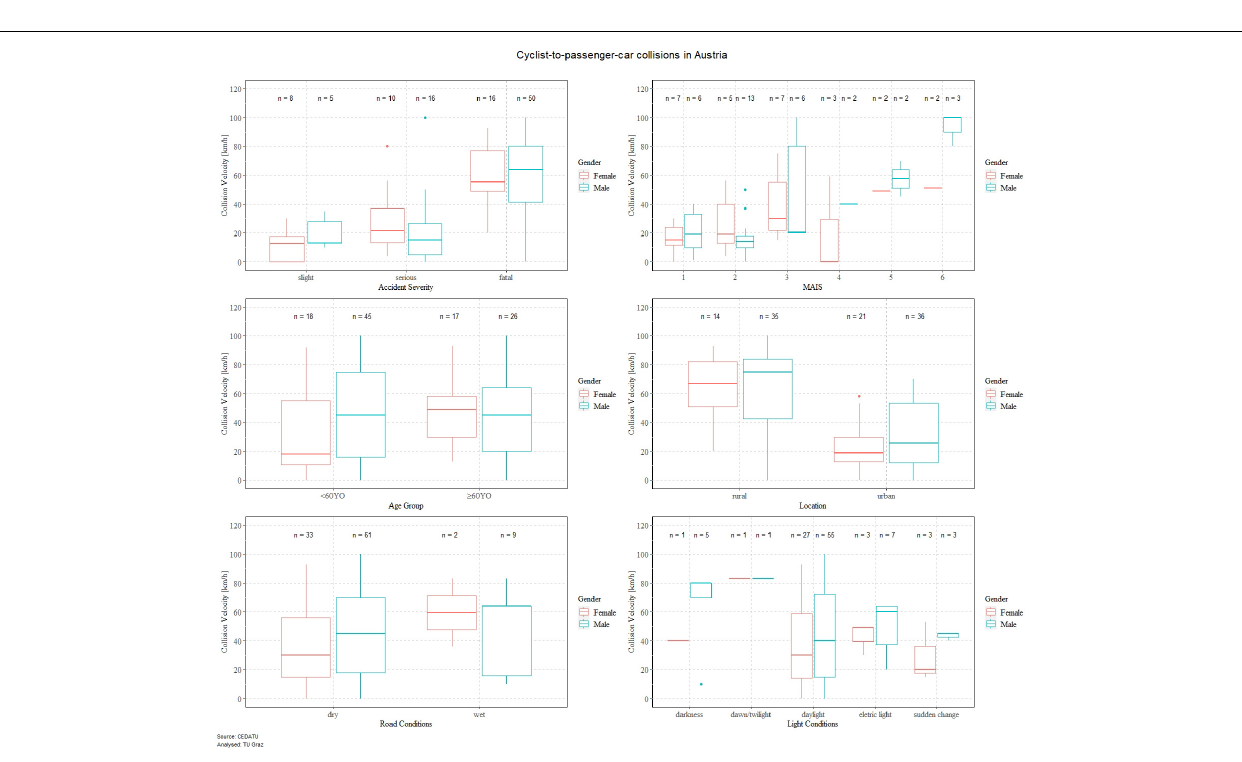
FIGURE 2 | In-depth analysis of Austrian accident data for cyclist-to-passenger car